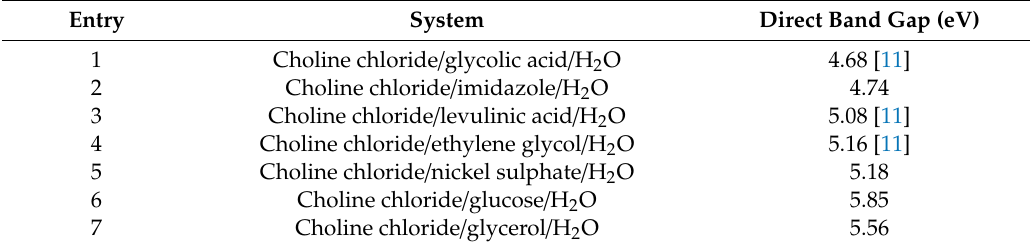
Table 4. Direct band-gap energies of choline chloride-based